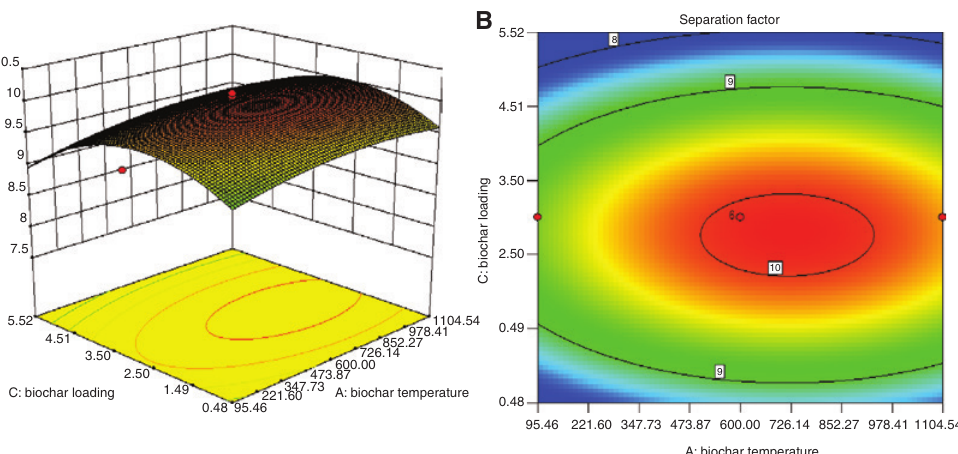
Figure 4: 3D surface plot (A) and contour plot (B) exhibiting the influences of PDMS concentration (wt%) and the BB loading amount on the separation factor.